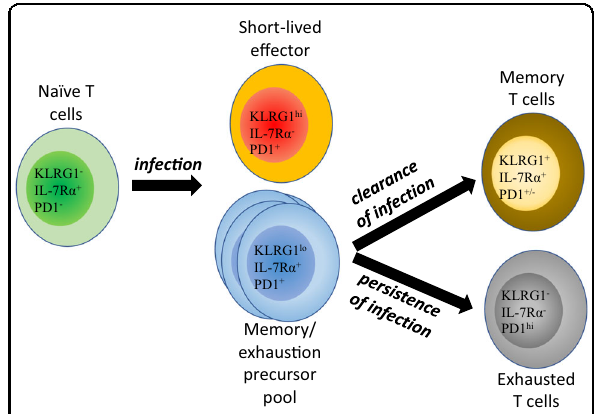
Fig. 2 Differentiation of exhausted T cells. T cell activation generates both short-lived effector cells with terminally differentiated features and memory precursors. If the infection is cleared without delay (acute infection), the short-lived effector cells die, and the memory precursors give rise to long-lived memory T cells. However, if the infection persists without resolution (chronic infection), the memory precursors generate PD1 + CXCR5 + TCF1 + progenitors